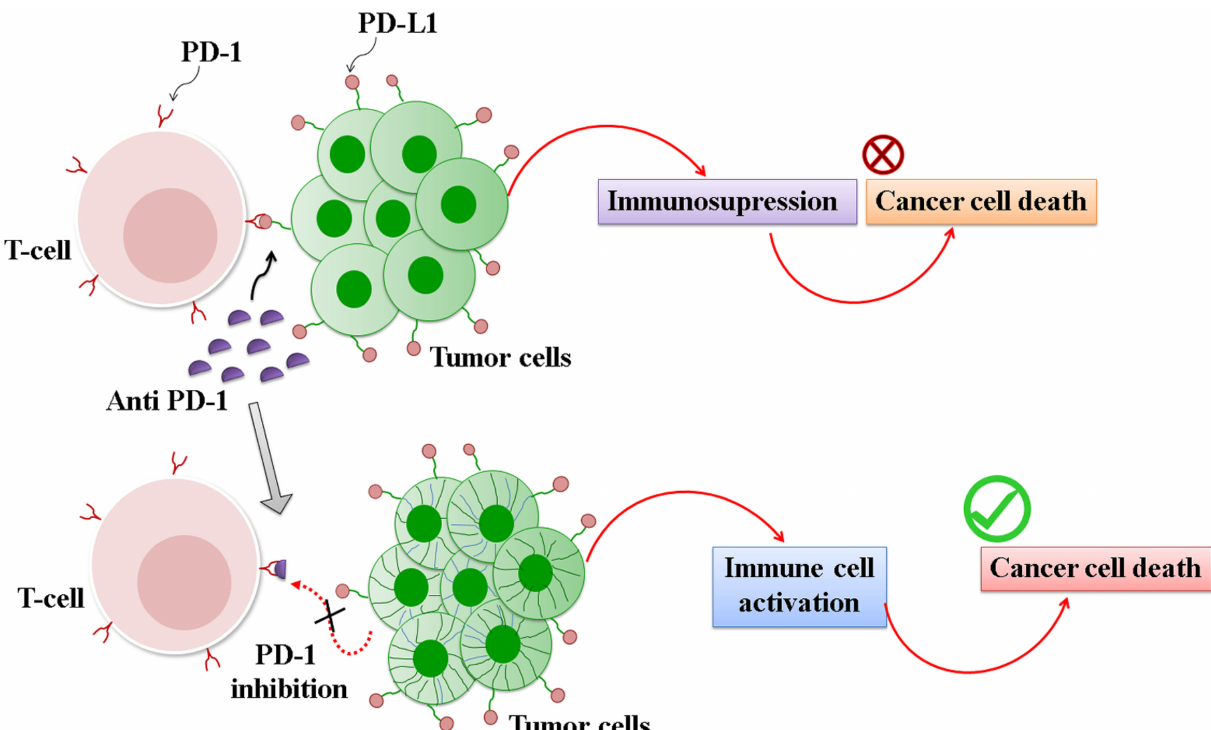
Figure 4. Mechanism of action of PD-I immune checkpoint inhibitors. PD-1 is a protein present on the T-cell surface. The corresponding ligand of PD-1 is called PD-L1, which is overexpressed in cancer cells. The interaction PD-1 and PD-L1blocks the cytotoxic effect of T cells. Pembrolizumab, a PD-1 inhibitor, prevents the interaction of PD-1 with its corresponding ligand and elicits an immune